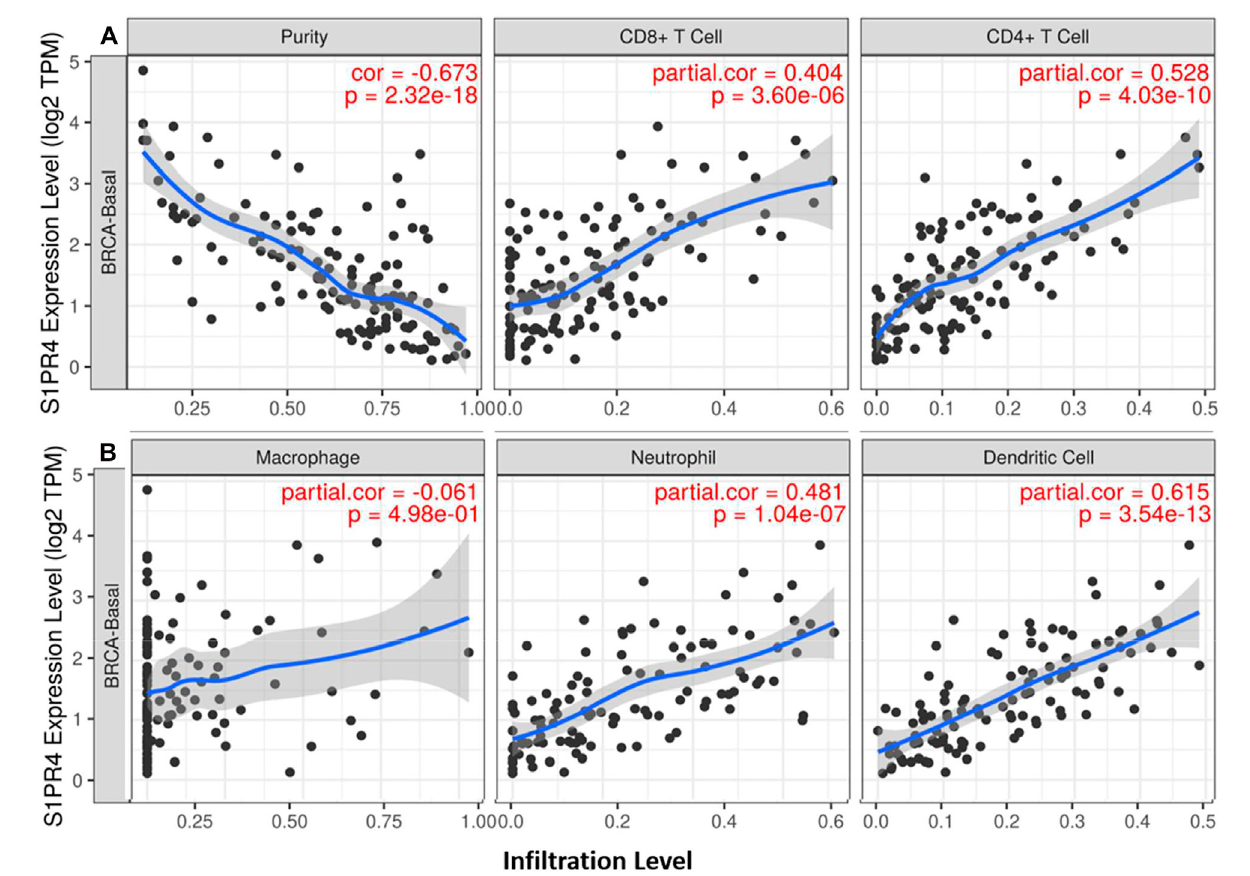
FIGURE 6 | Correlation of S 1 PR4 expression with immune in fi ltration level in breast cancer patients. SGPP1 expression is signi fi cantly correlated with in fi ltrating levels of CD8+ T cells, CD4+ T cells (A) , neutrophils and dendritic cells in basal-like BC, but not with macrophage cells (B)